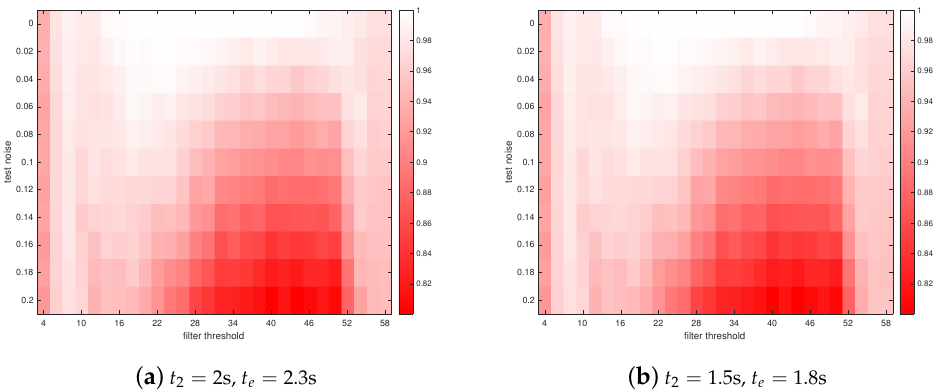
Figure 12. The performance score C p with different starting time t 2 with l = 4. In each sub-figure, the vertical axis denotes various levels of the salt-and-pepper noise at the testing stage. The horizontal axis denotes the threshold f 0 (increased by 2 units) of the low-pass filter. The performance is barely affected by the time interval.